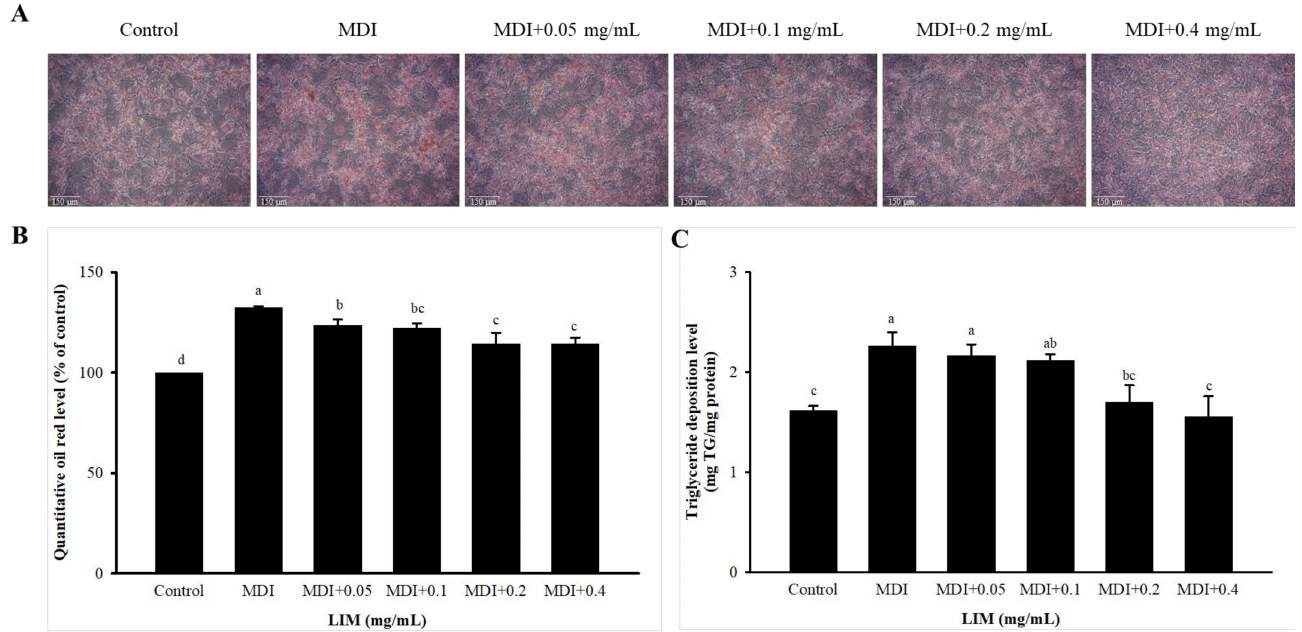
Figure 2. Effect of limonene (LIM) on lipid accumulation in 3T3-L1 adipocytes. ( A ) Intracellular lipid droplets were stained with oil red O and visualized by a microscope with 200 × magnification. ( B ) The stained lipid droplets were solubilized with isopropanol and the absorbance was read at 510 nm using a microplate reader. ( C ) TG content assay of differentiated 3T3-L1 adipocytes treated with different concentrations of LIM. The cells were collected every two days, and the histogram showed the relative fold change compared with the control group (set as 100%). The significant difference was evaluated by Tukey’s test for lipid accumulation. Data were the means ± SD ( n = 3). The values represented by different alphabets (a–c) were considered statistically significant between the different groups ( p < 0.05). The differentiation medium (MDI) (containing DMEM supplemented with IBMX (0.5 mM), dexamethasone (1 µ M), and insulin (10 µ